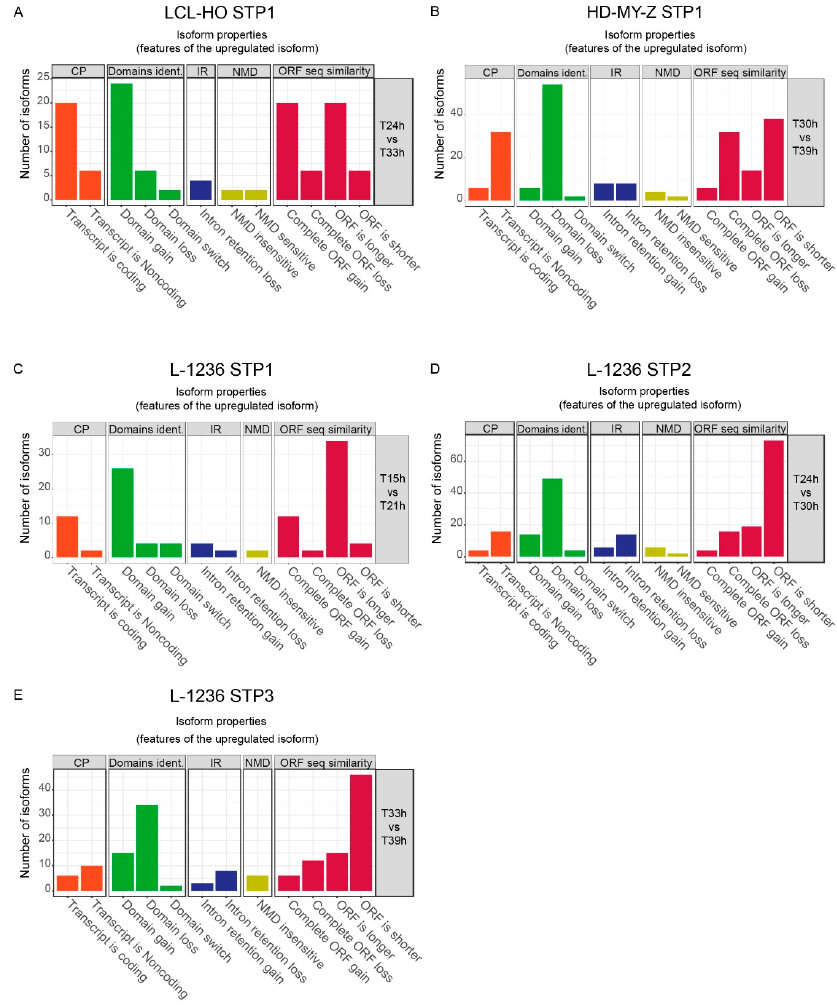
Figure 2. Computational analysis of the isoforms involved in the STPs shows that the loss of coding functionality and potential domain loss are the main consequences of changes in isoform expression. We performed a computational analysis only on the highly expressed genes and isoforms with changing expression in each STP. The analysis included coding potential (CP), identification of